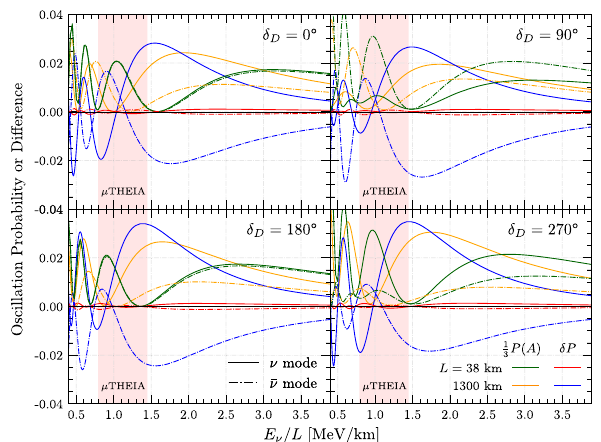
Fig. 1 The oscillation probability 1 P ( A ) and oscillation probability 3 difference δ P μ e ≡ P μ e ( A ) − P μ e ( A = 0 ) between the matter-induced and vacuum cases as a function of E ν / L for both neutrino (solid) and anti-neutrino (dashed) modes. Both μ THEIA ( L = 38km with green line for P μ e ( A )/ 3 and red one for δ P μ e ) and DUNE ( L = 1300km with yellow line for P μ e ( A )/ 3 and blue one for δ P μ e ) are illustrated. The pink band indicates the μ THEIA energy range [30, 50]MeV